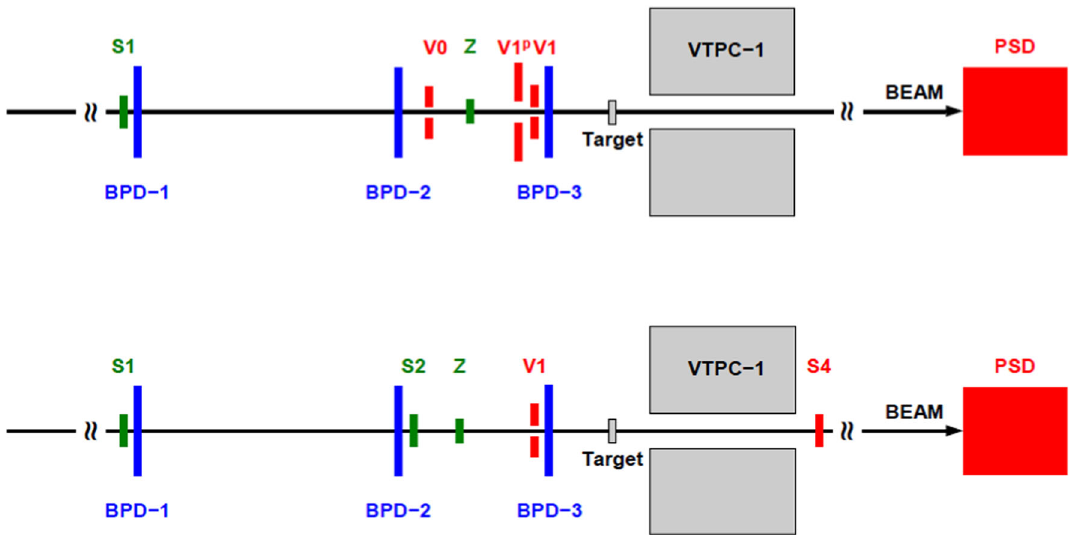
Fig. 2 The schematic of the placement of the beam and trigger detec- tors in high-momentum (top) and low-momentum (bottom) data taking configurations showing beam counters S, veto counters V and beam